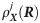
C and O position-dependent binding probabilities for diluted concentrations of sevoflurane in the bulk.(A) Shown is the ensemble average structure of the channel (white) along with the density ρXj(R) of sevoflurane (orange and cyan) in each of the binding sites (isovalues of 9x10-5 Å-3). Densities pertaining to sites S4S5 linker, S6P-helix and S4Pore are indicated with yellow symbols. As described in Computational Methods, the determination of ρXj(R) involved reweighing the marginal probability ρX(nj) at the binding site j by the local equilibrium density of sevoflurane ρX(R|nj). The marginal ρX(nj) was computed by coarse-graining over state probabilities in S2 Fig whereas, ρX(R|nj) was calculated from the centroid distributions of docking solutions shown in Fig 1B and 1C. (B) Projection of ρXj(R) along the transmembrane direction z of the system, ρXj(z).